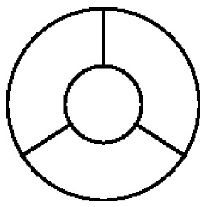
Figure 1. Four-loop vacuum